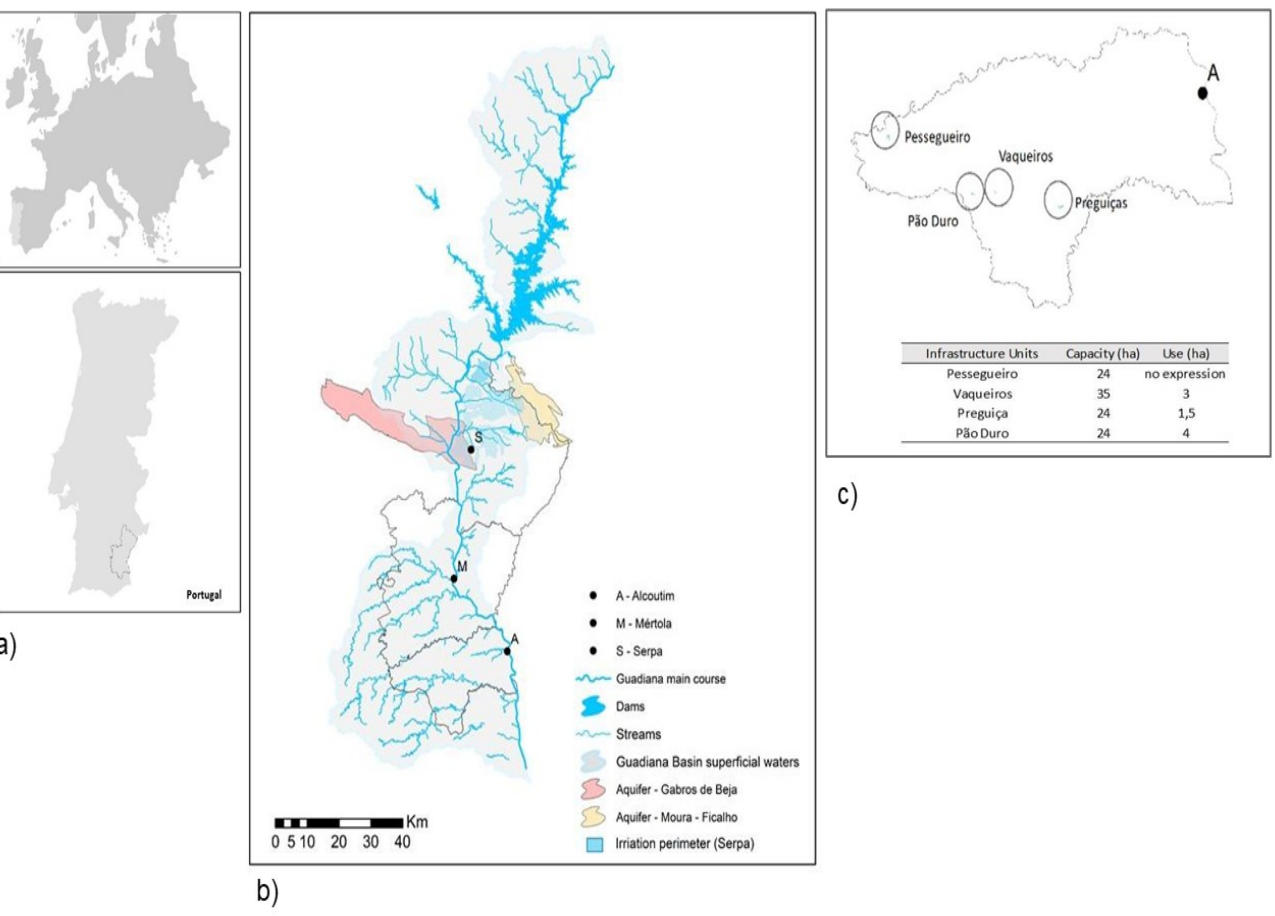
Figure 2. ( a ) Location of the study area, ( b ) water resources within the case study, and ( c ) location of existing dams.